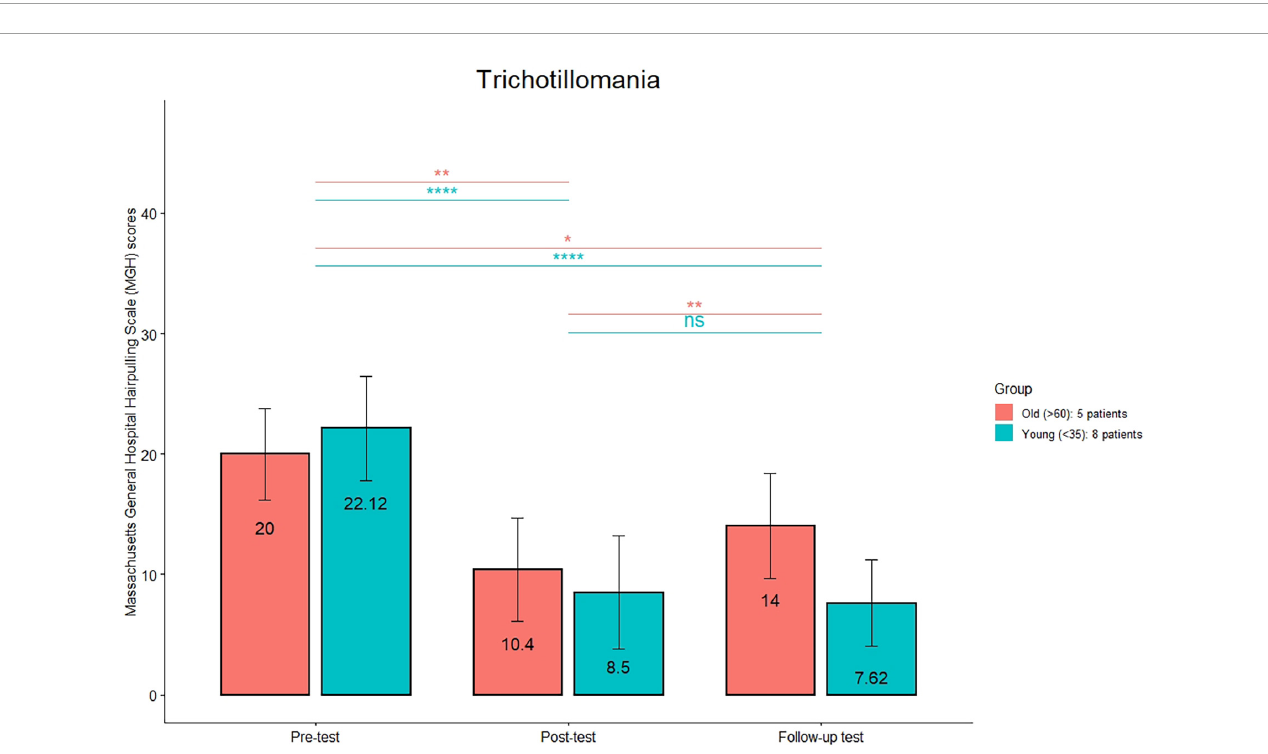
FIGURE2 Massachusetts General Hospital Hair pulling Scale (MGH) mean scores are reported for the young and old subgroups in the trichotillomania group at the three timepoints (pre-treatment, post-treatment, and 1 month follow-up). **** p < 0.0001; ** p < 0.01; * p < 0.05; n.s.: not significant.